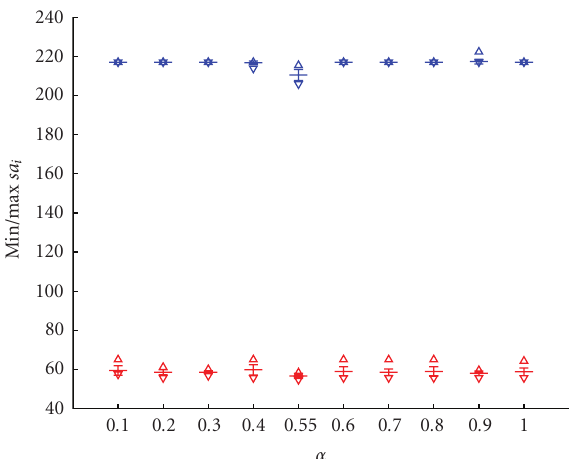
Figure 5: Variance of the minimal and maximal percentage of the postinitial signal intensity sv p for 20 runs in function of the initial steps size α varied from 0.1 to 1. As an optimal value, we obtain α = 0 .